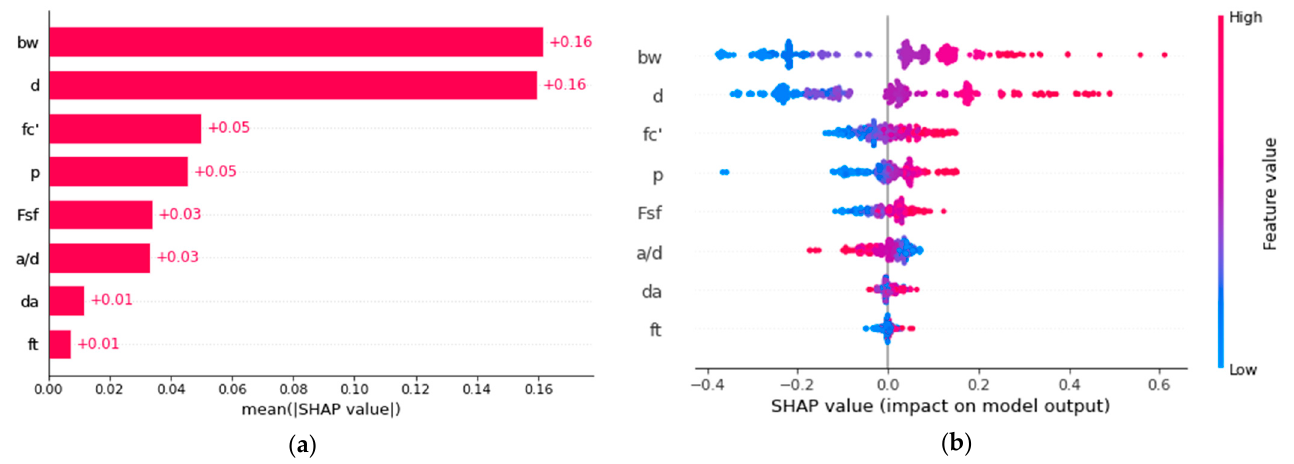
Figure 9. The relative importance of each feature and SHAP summary plot: ( a ) relative importance; ( b ) SHAP summary plot.